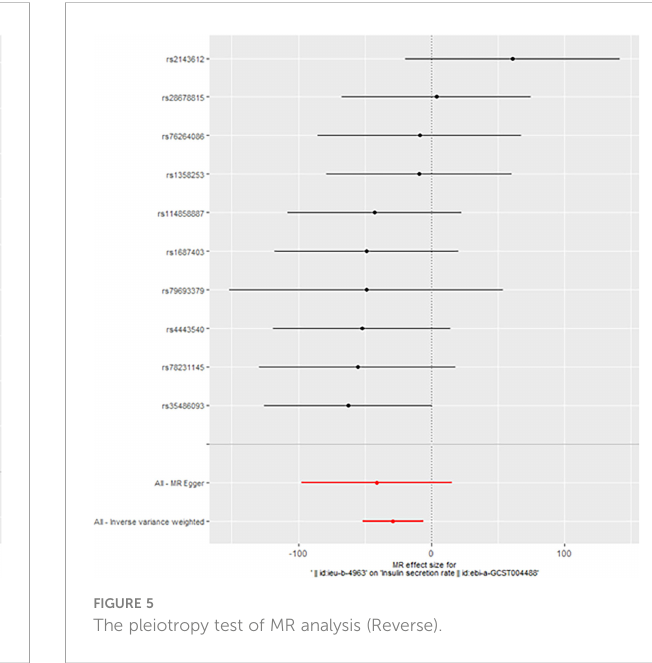
FIGURE 3 The retention analysis of the SNPs (Forward).